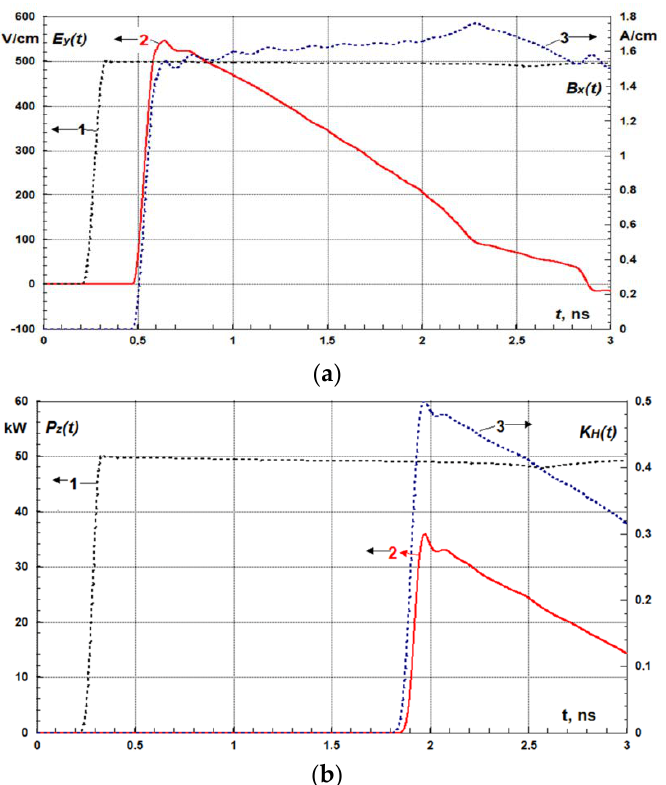
Figure 3. Time ‐ dependent parameters of calculation. ( a ) 1 = external E y ( t ; z = 6 cm); 2 = E y (t ; R 1 ) inside the antenna; 3 = magnetic field B x (t ; R 1 ) . ( b ) 1 = external power flow P a 1,in (t ; z = 6 cm ) throughout the antenna aperture A a 1 ; 2 = received power P a 1 , rec ( t ; z = 53 cm); 3 = antenna factor K H .